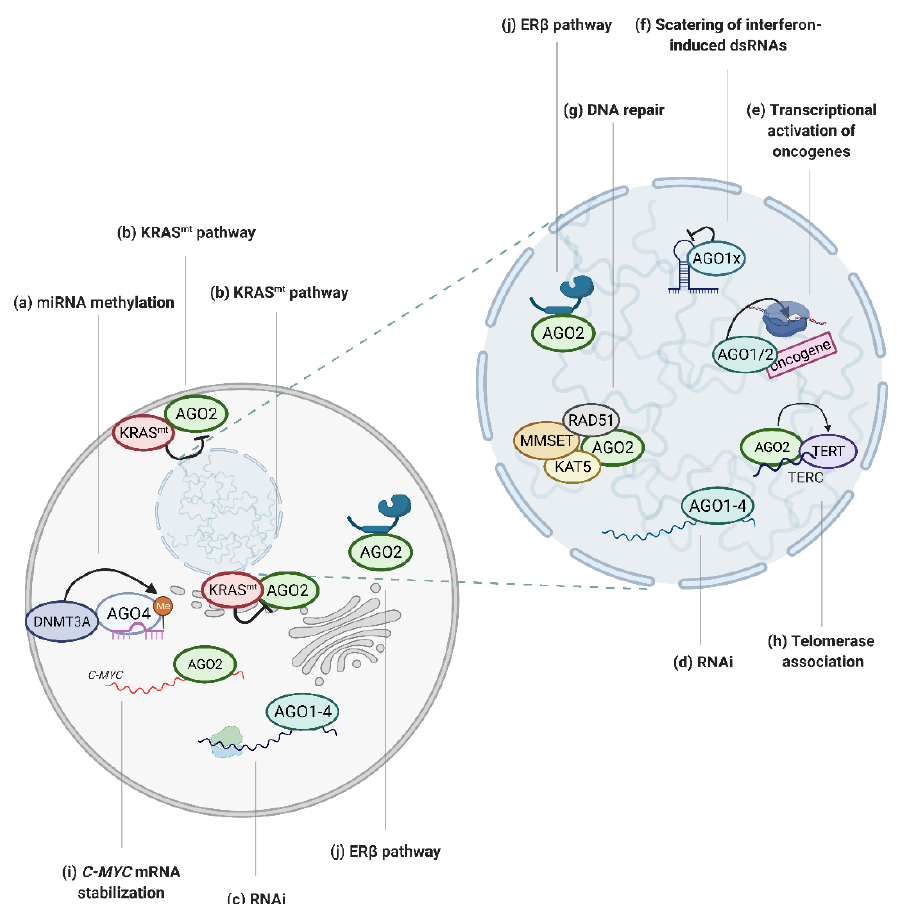
. miRNA methylation, which inhibits miRNA activity [38]; ( b ) mutated KRAS protein negatively Figure 2. Graphical depiction of AGO-regulated tumor associated processes. ( a ) AGO4 enhances miRNA methylation, regulates AGO2 activity [28,29]; ( c ) AGO proteins mediate RNAi in cytoplasm [1] and ( d ) nucleus [47] which inhibits miRNA activity [38] ; ( b ) mutated KRAS protein negatively regulates AGO2 activity [28,29] ; ( c ) AGO pro- in cancer cells; ( e ) AGO1 and AGO2 bind to promoters of oncogenes to activate transcription [18–20]; teins mediate RNAi in cytoplasm [1] and ( d ) nucleus [47] in cancer cells; ( e ) AGO1 and AGO2 bind to promoters of ( f ) AGO1 translational read-through variant, AGO1x, inhibits interferon-induced apoptosis via the oncogenes to activate transcription [18 – 20] ; ( f ) AGO1 translational read-through variant, AGO1x, inhibits interferon-in- depletion of nuclear dsRNA [22]; ( g ) AGO2 recruits RAD51, MMSET and KAT5 proteins to dsDNA duced apoptosis via the depletion of nuclear dsRNA [22] ; ( g ) AGO2 recruits RAD51, MMSET and KAT5 proteins to breaks to facilitate DNA repair [33,34]; ( h ) AGO2 promotes telomerase activity [37]; ( i ) AGO2 dsDNA breaks to facilitate DNA repair [33,34] ; ( h ) AGO2 promotes telomerase activity [37] ; ( i ) AGO2 tethers MYC mRNA and increases its stability [27] ; ( j ) AGO2 activity is regulated via ERβ [31] . Created with BioRender.com (accessed date: 21 January 2021).